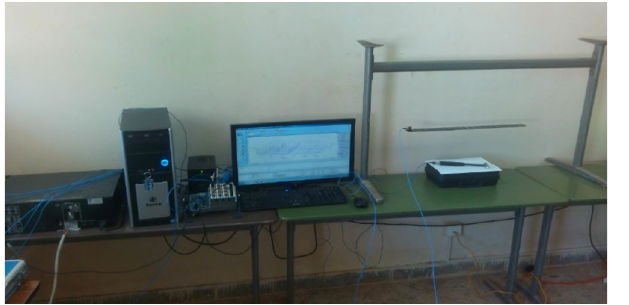
Figure 5. Experimental setup 24